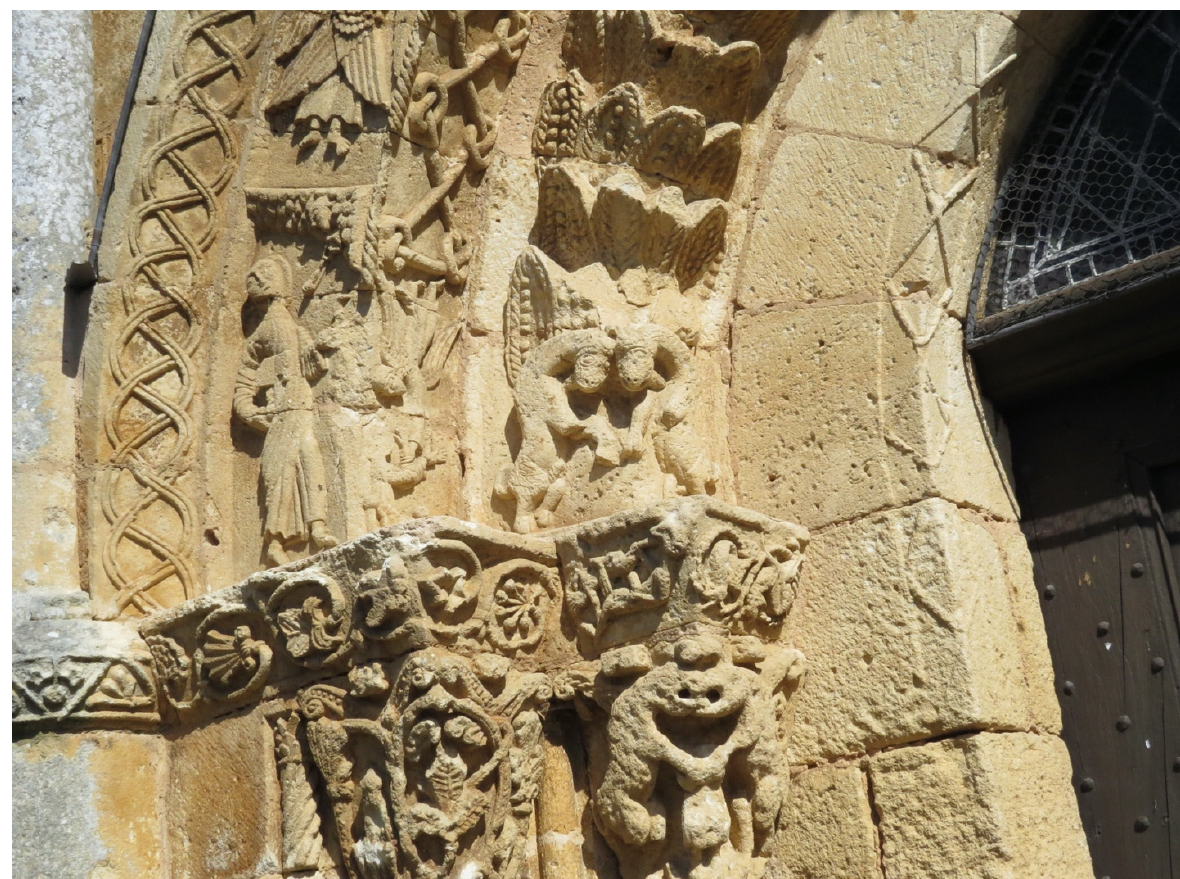
Figure 12. Lions, foliage, capitals, and psychomachia frieze, detail of left-hand side, west